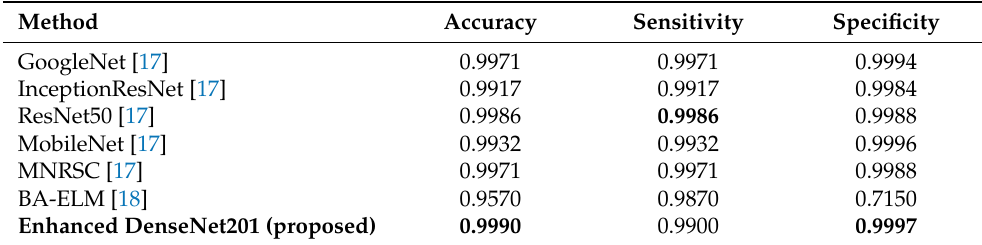
Table 6. Comparison with the state-of-the-art deep neural network methods.